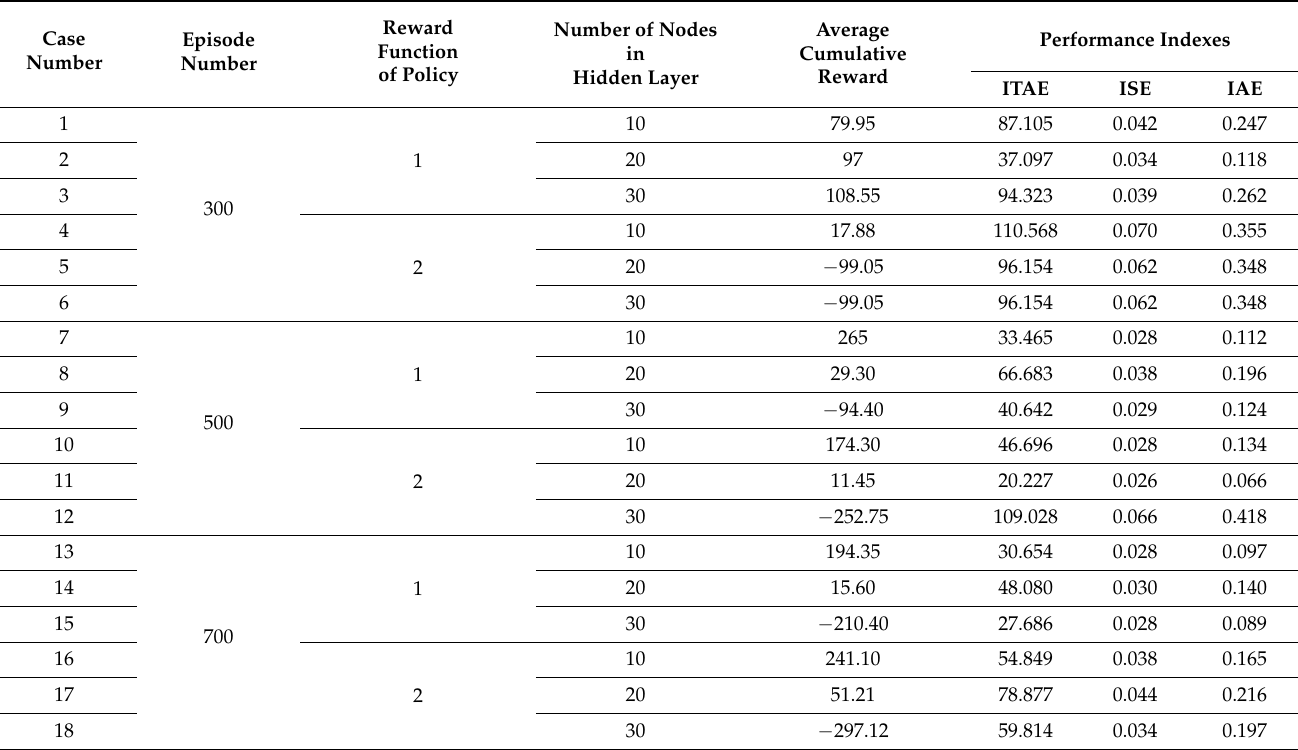
Table 2. Grid search results of liquid level